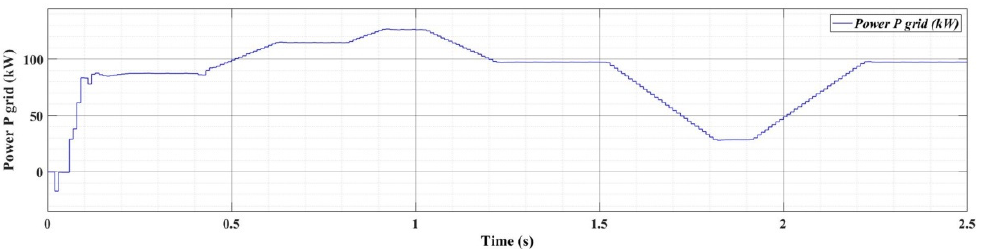
Figure 45. The time evolution of the power flow P between the PV and the main grid (signal evolution of the type 2 PV array).